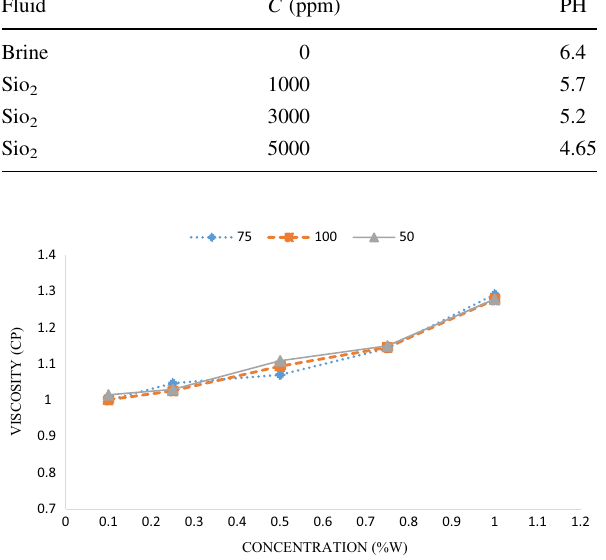
Fig. 12 Viscosity calculations for five different nanoparticle solutions